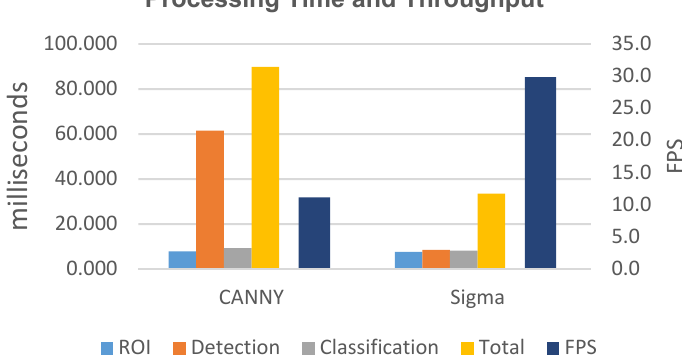
Figure 15. Performance data for the Canny and Sigma algorithms.